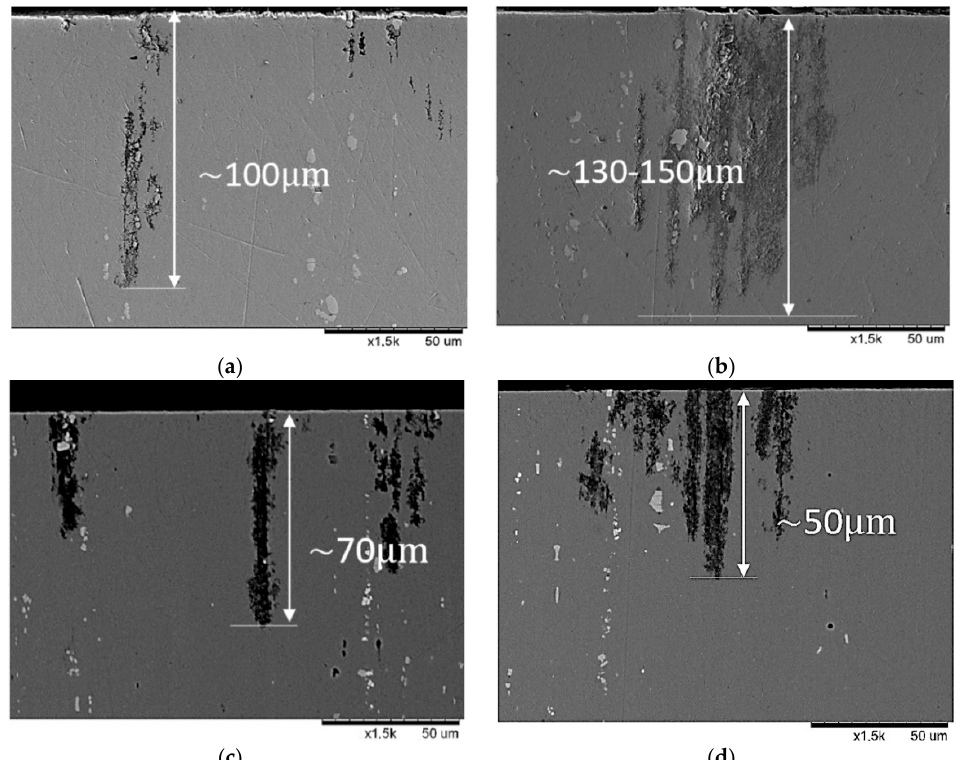
Figure 12. Sample surfaces following potentiodynamic polarization in 0.05 M NaCl: ( a ) CG, ( b ) HE, ( c ) HT1, and ( d ) HT2.